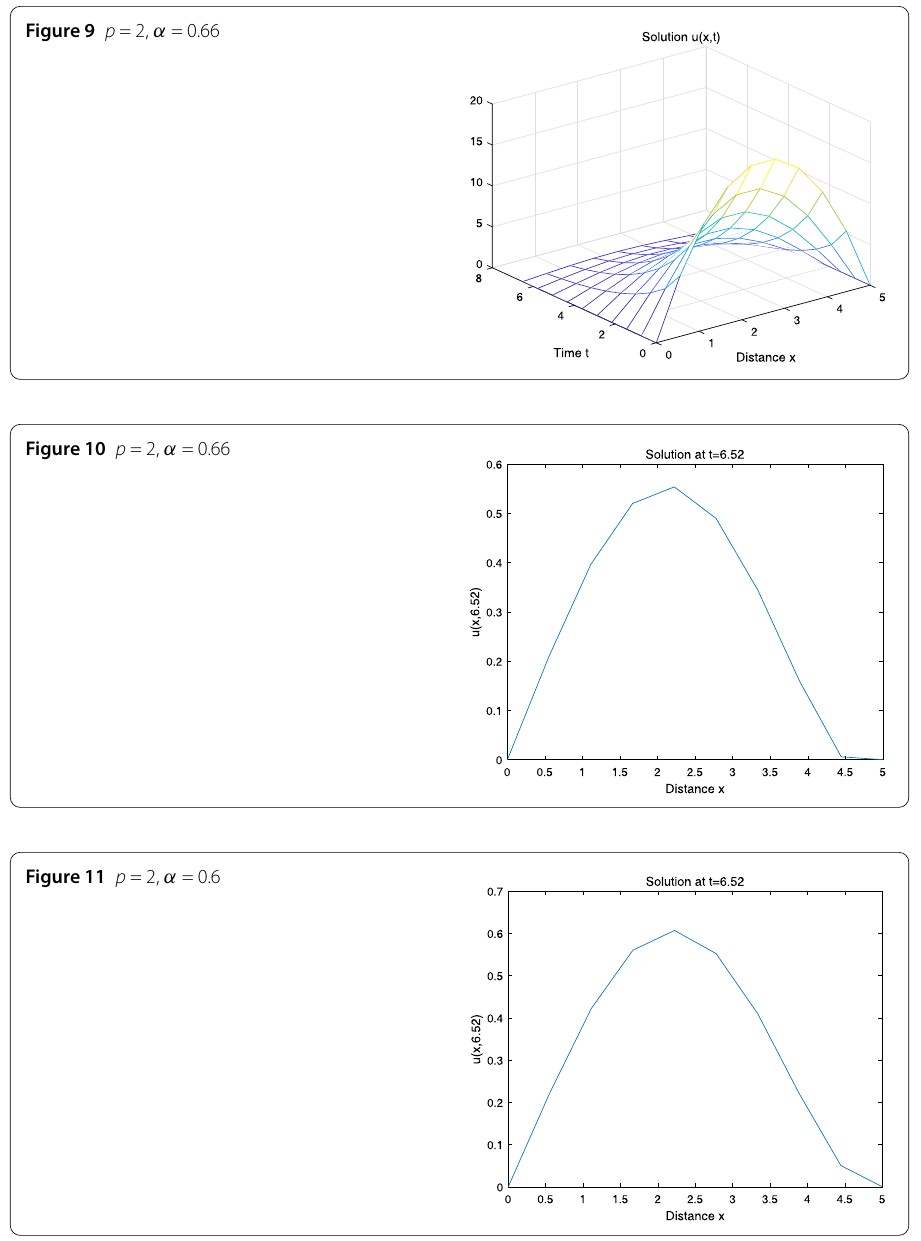
Figure 9 p = 2, α = 0.66